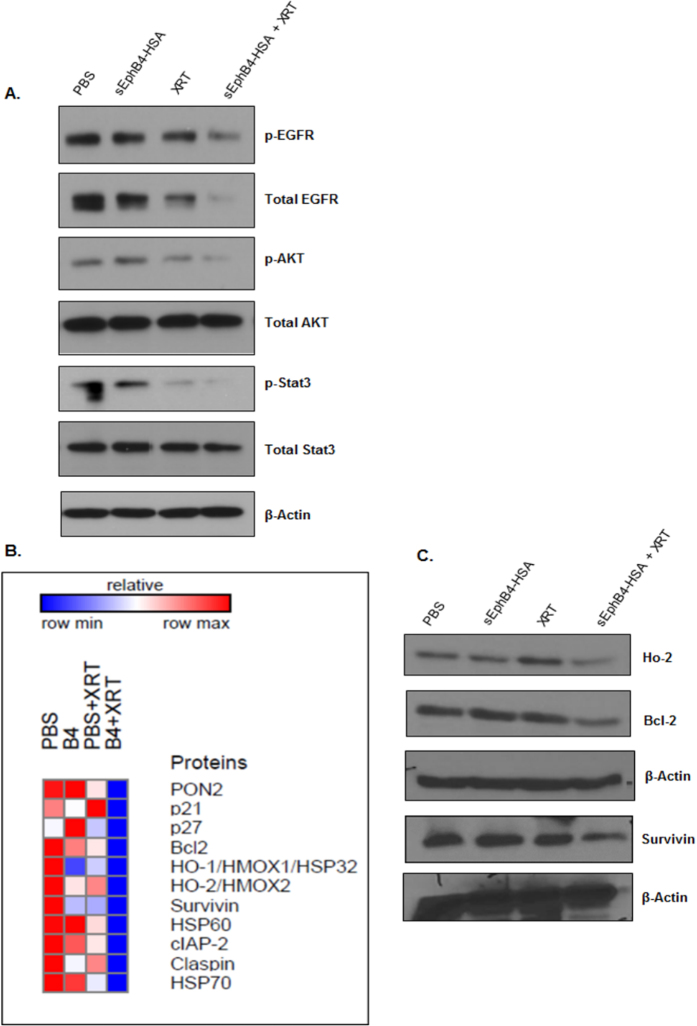
EphB4 targeting in combination with ionizing radiation exposure alters the expression of apoptotic and tumor growth promoting molecules in CUHN013 tumors.Western blot analysis shows decreased phosphorylation or decreased levels of proteins implicated in tumor growth and cell survival in CUHN013 tumors treated with sEphB4-HSA and radiation compared to tumors treated with a single agent. (B) A heat map generated based on the results of a human apoptosis antibody array using GeneE software (Broad institute, USA) depicts decreased expression of survival markers in CUHN013 tumors treated as indicated. (C) Validation of hits by western blotting shows decreased levels of pro-survival proteins such as Ho-2, Bcl-2, and survivin in tumors treated with sEphB4-HSA combined with radiation (XRT) compared to tumors treated with a single agent.